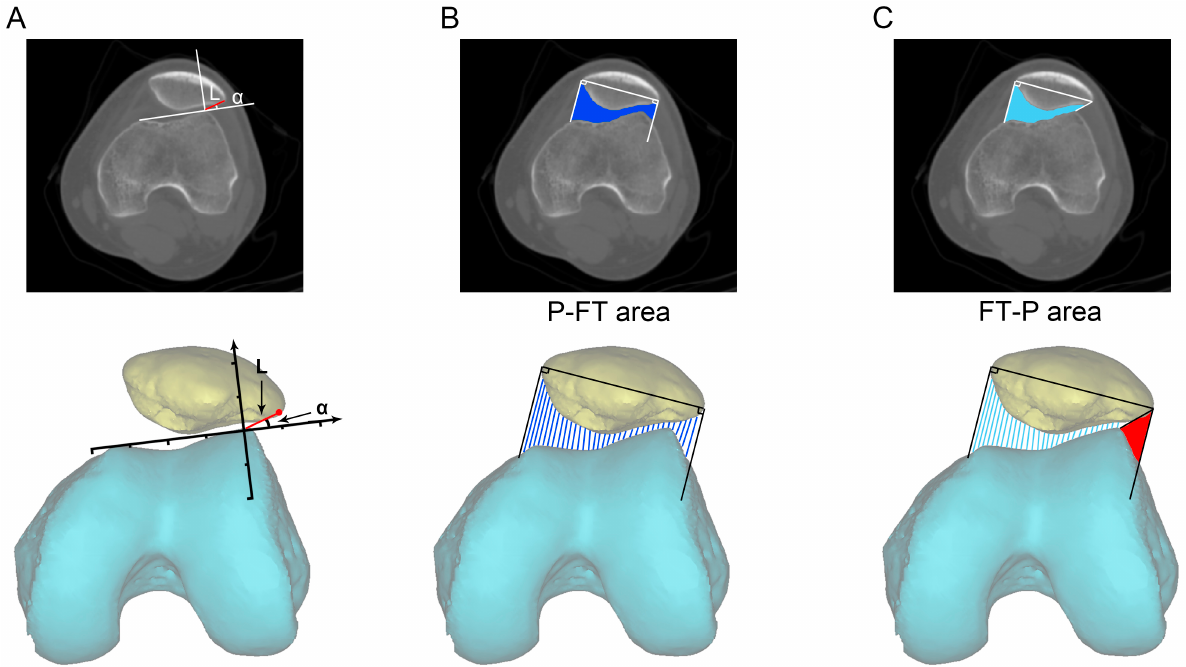
Figure 3. Two newly designed assessment indicators for the patellofemoral joint. ( A ) In an axial CT image of the knee joint, on the plane connecting each of the highest points of the medial and lateral femoral condyles, a connecting line was created between the outermost point of the patella and the highest point of the lateral femoral condyle. The length of the line was considered as L, and the angle between this line and the line connecting each of the highest points of the medial and lateral femoral condyles was regarded as α (with the line connecting each of the highest points of the medial and lateral femoral condyles as the X -axis and the line from the highest point of the lateral condyle as the Y -axis; this allowed us to establish a coordinate system for L and α ). ( B ) Patella-femoral trochlear (P-FT) area: in an axial CT image of the knee joint, the longest axis between the medial and lateral sides of the patella was first drawn on the plane connecting each of the highest points of the medial and lateral femoral condyles, and two lines perpendicular to the long axis were created at the outermost and medial points of the patella. The cross-sectional area from the lower edge of the patella to the femoral trochlear groove between two vertical lines was measured (the area marked in blue). ( C ) Femoral trochlear-patella (FT-P) area: in the axial CT image of the knee joint, the longest axis between the medial and lateral sides of the patella was first drawn on the plane connecting each of the highest points of the medial and lateral femoral condyles. A line perpendicular to the long axis was then drawn at the medial point, and a connecting line was created between the outermost point of the patella and the highest point of the lateral femoral condyle. The cross-sectional area from the lower edge of the patella to the femoral trochlear groove between the two connecting lines was then measured (the area shown in light blue). The area of the red region indicates the difference between the P-FT area and the FT-P area.